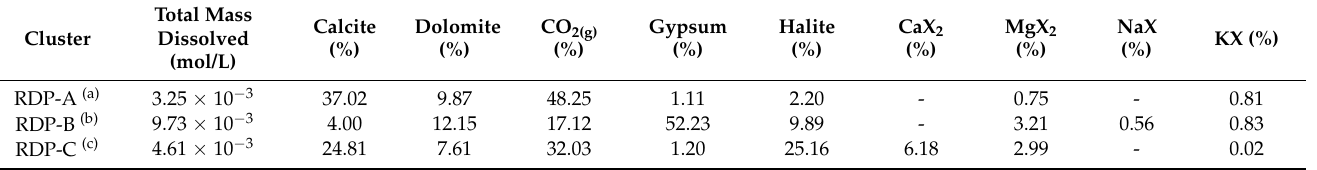
Figure 8. Graph of the inverse geochemical results using PHREEQC for the different RDPs (Recharge-Discharge-Pathways) and their associated reference spring. Results in moles per liter of H 2 O. Positive and negative values indicate species dissolution and precipitation, respectively. Table 2. Summary of the results obtained by the inverse modeling using PHREEQC. For every RDP cluster, the results are given in terms of the average of the total mass of dissolved species in GW, and the corresponding percentage of mass of the dissolved